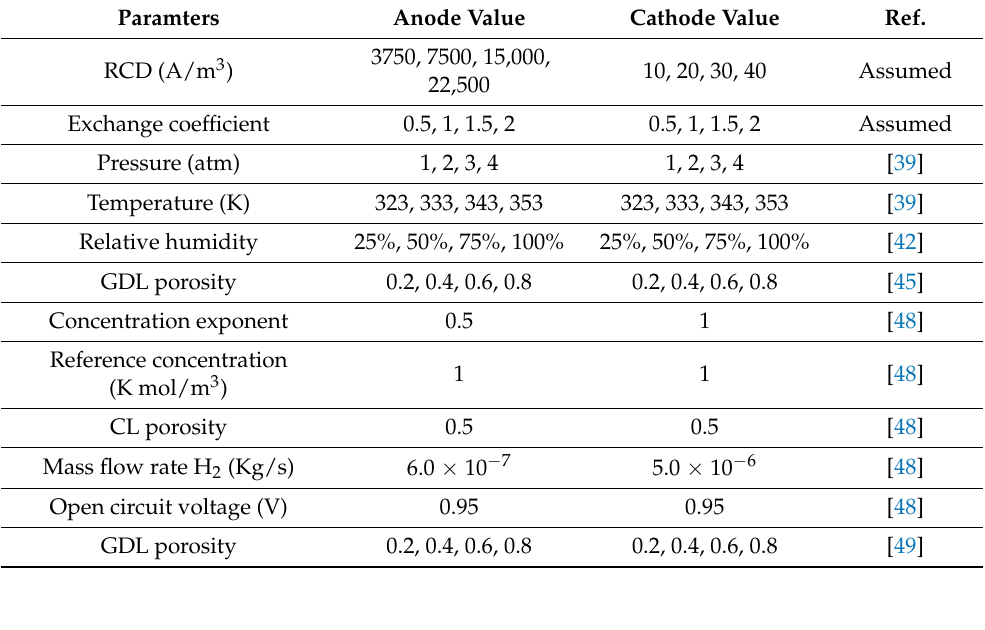
Table 2. Operating and electrochemical parameters of PEMFC.